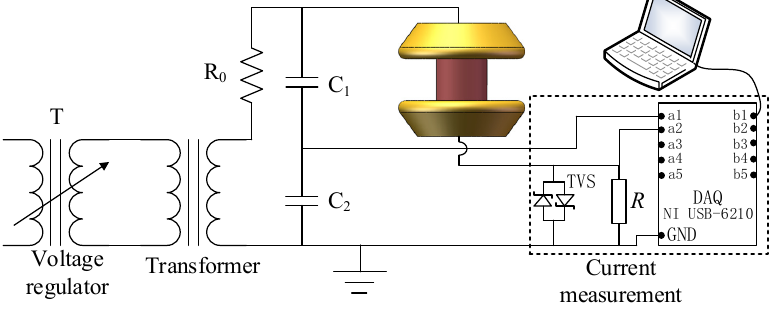
Figure 1 . Test circuit structure. Figure 1. Test circuit